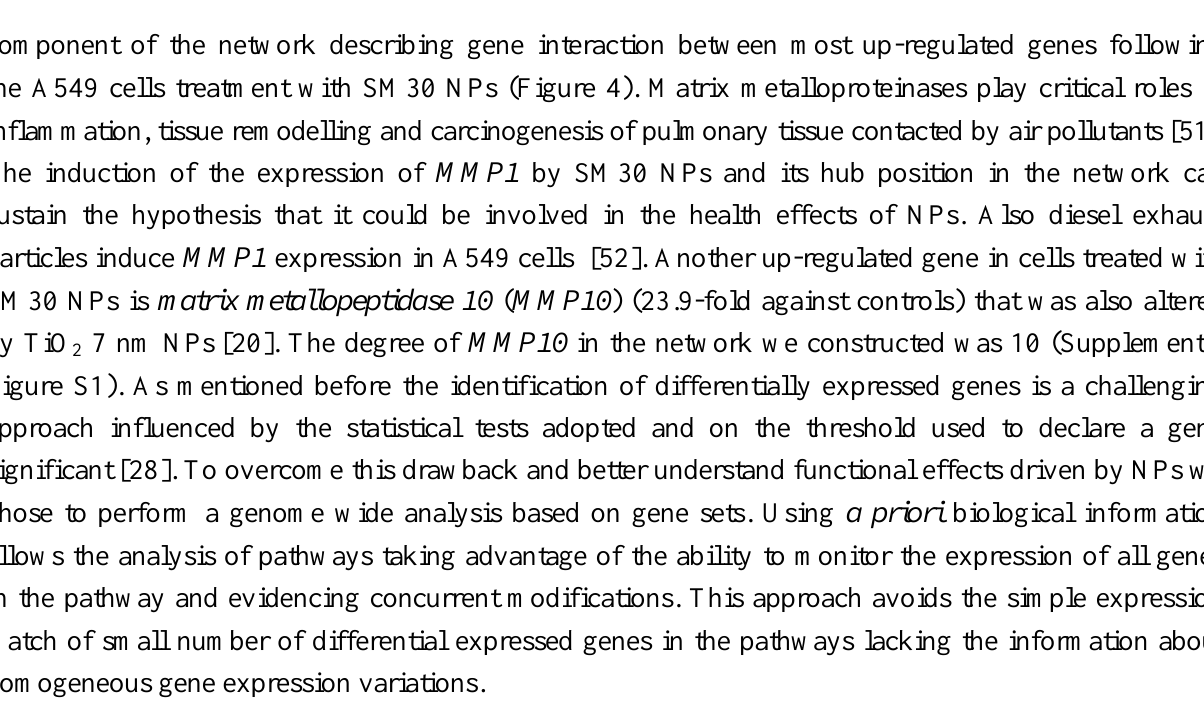
Figure 4. Regulatory network reconstructed using literature information for nodes with degree higher than 20. Nodes of the network are colored according to their expression in cells treated with SM30 while node border is colored according to node degree (blue is for degree higher than